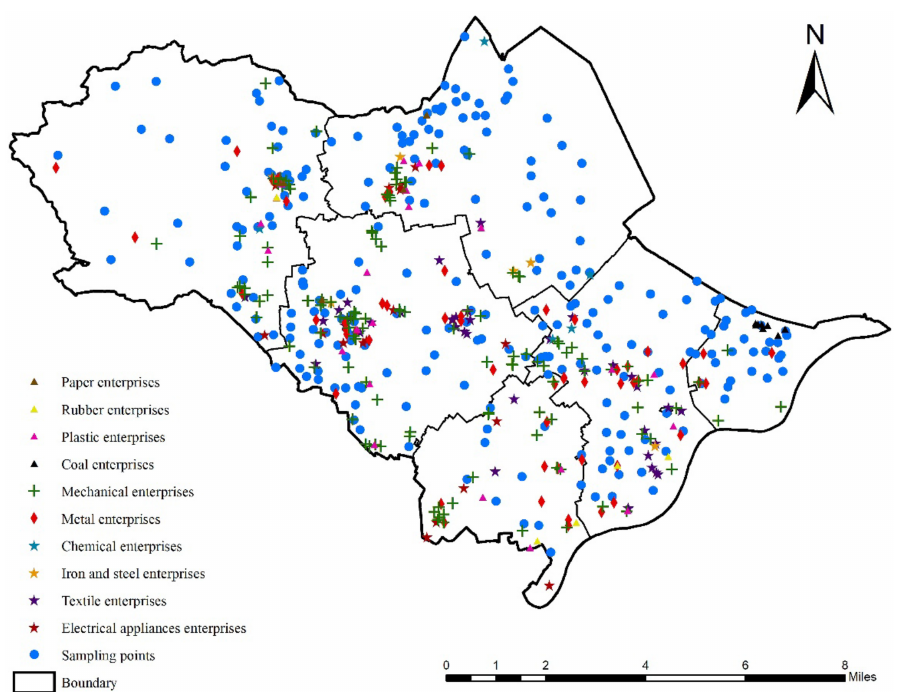
Figure 8. Map showing the distributions of the different types of industrial enterprises and the sampling